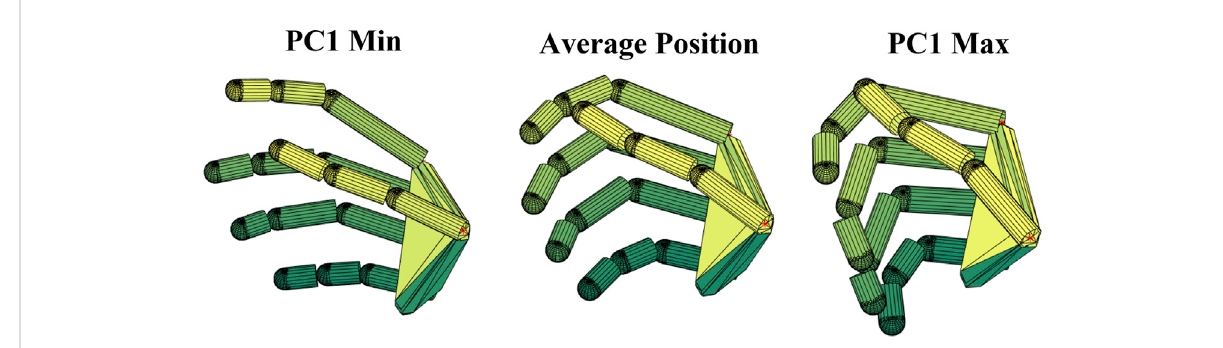
FIGURE 8 Movement of the hand according to the activation of the fi rst postural synergy. PC1 Min corresponds to an extended hand, PC1 Max to progressive fl exion of PIP, DIP and MCP joints.